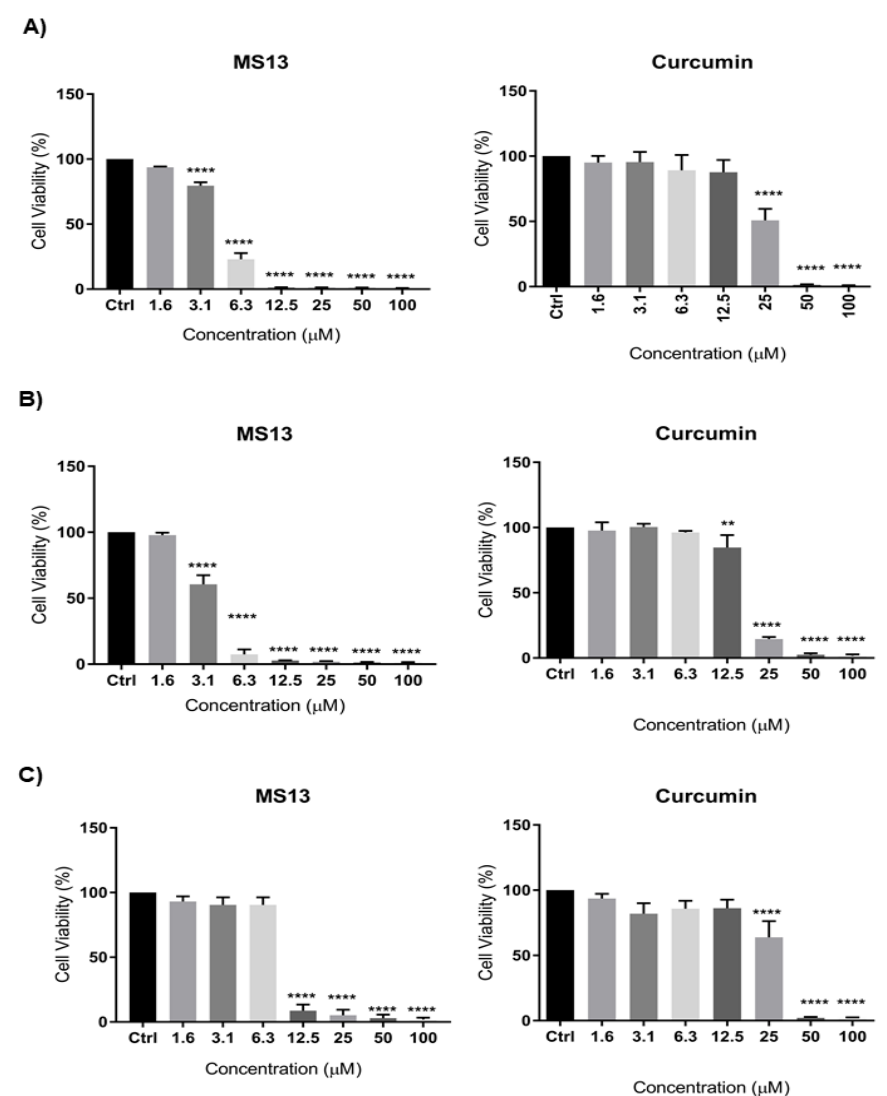
Figure 1. The cytotoxic effects of MS13 and curcumin at different concentrations on ( A ) NCI-H520, ( B ) NCI-H23, and ( C ) MRC9 cell lines compared to untreated sample (Ctrl) at 72 h of incubation. The experiments were performed in triplicates, and results were compared between three independent experiments. The data are presented as means of percentage of cell viability and comparison between data sets were statistically analyzed using ANOVA. Asterisks indicate statistically significant differences between the means of the values obtained with treated versus untreated cells (** p < 0.01, and **** p < 0.0001).